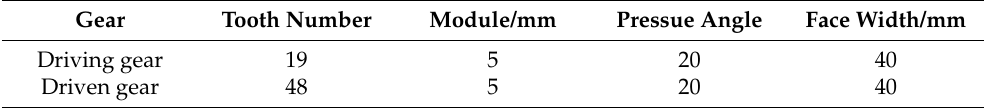
Table 2. Related parameters of standard spur gear. Table 3. Main mechanical property parameters of special alloy steel material at room temperature.